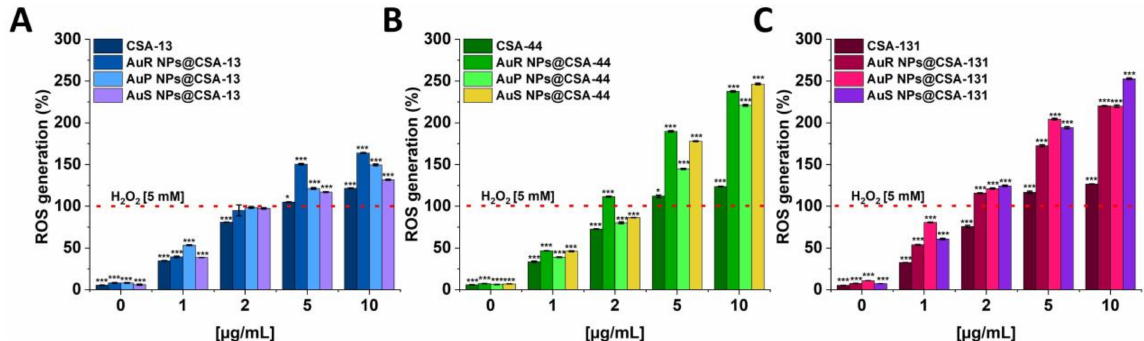
Figure 4. Induction of reactive oxygen species (ROS) generation in C. albicans 1408 was evaluated by the DFCH-DA fluorimetric assay. Formation of ROS in cells subjected to CSA-13, AuR NPs@CSA-13, AuP NPs@CSA-13, AuS NPs@CSA- 13 ( A ); CSA-44, AuR NPs@CSA-44, AuP NPs@CSA-44, AuS NPs@CSA-44 ( B ); and CSA-131, AuR NPs@CSA-131, AuP NPs@CSA-131, AuS NPs@CSA-131 ( C ) ranging from 1 to 10 µ g/mL was presented. The dashed line corresponds to the effect obtained with the 5 mM hydrogen peroxide. The results show the mean ± SD, n = 3; * indicates statistical significance at ≤ 0.05 and *** ≤